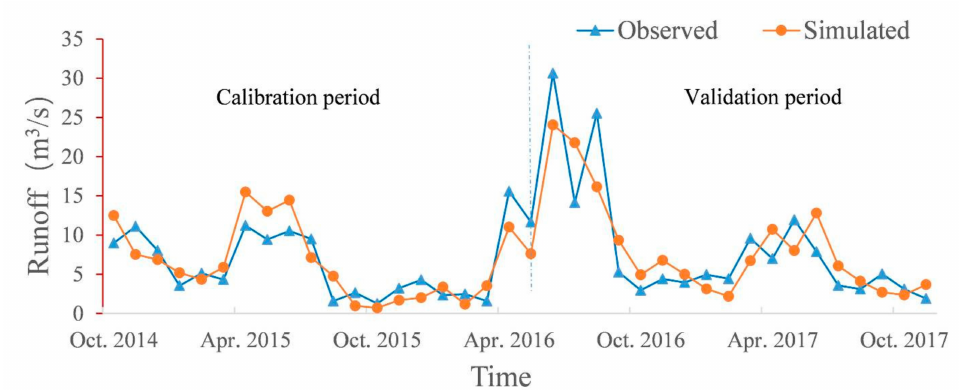
Figure 2. Comparision between simulated and observed runoff.